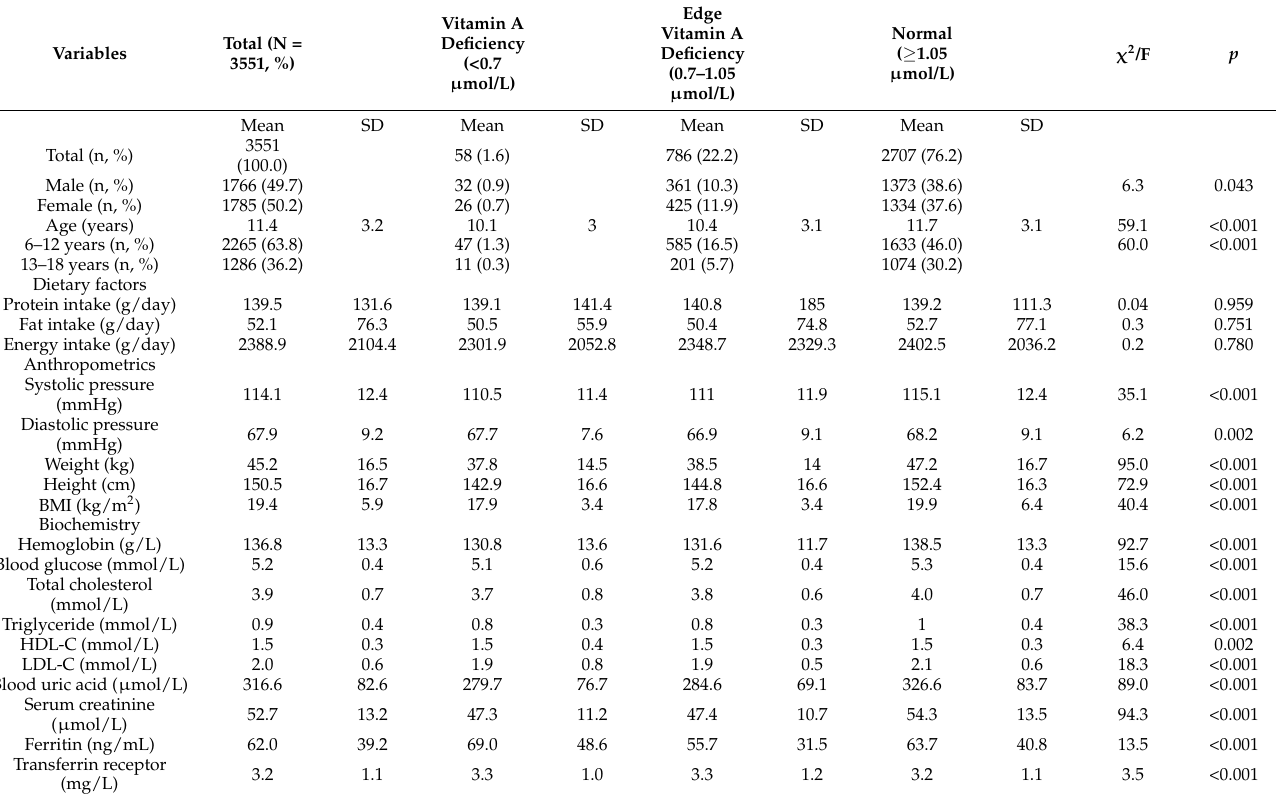
Table 1. Sample characteristics according to vitamin A status (mean values and standard deviations; numbers and